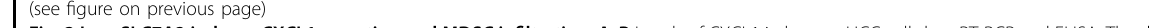
Fig. 3 Low SLC7A2 induces CXCL1 secretion and MDSC in fi ltration. A , B Levels of CXCL1 in human HCC cells by qRT-RCR and ELISA. The data are shown as the mean ± SD from the at least three independent experiments; * P < 0.05, ** P < 0.01. C Levels of CXCL1 by qRT-RCR in Hepa1-6-shSLC7A2 tumor-bearing mice tumors ( n = 5). The data are shown as the mean ± SD from the at least three independent experiments; ** P < 0.01. D ELISA of CXCL1 in subcutaneous tumors and in blood from tumor-bearing mice. ( n = 5). The data are shown as the mean ± SD from the at least three independent experiments; * P < 0.05, **** P < 0.0001. E Labeled CD11b + Gr-1 + cells myeloid MDSCs from Hepa1-6 bearing mice were determined by fl uorescence-activated cell sorted (FACS). F Schematic diagram about the migration of MDSCs. G Conditioned media (CM) from Hepa1-6-shSLC7A2 and their controls clones were placed in the lower chambers. Freshly Myeloid MDSCs were put in the upper chambers and invasion for 24 h. Total numbers were counted. The data are shown as the mean ± SD from the at least three independent experiments; * P < 0.05. H Pre-treated with mCXCL1 (0, 10,100 ng/mL, 24 h), the chemotaxis of mouse MDSCs is shown. The data are shown as the mean ± SD from the at least three independent experiments; **** P < 0.0001. I Representative IHC staining images for SLC7A2 and CD11b in human HCC tissues. Scale bars, 200 µm (upper), 50 µm (lower). J Kaplan – Meier analysis of the associations between MDSCs in fi ltration and overall survival in the HCC cohort. The data are shown as the mean ± SD; ** P <